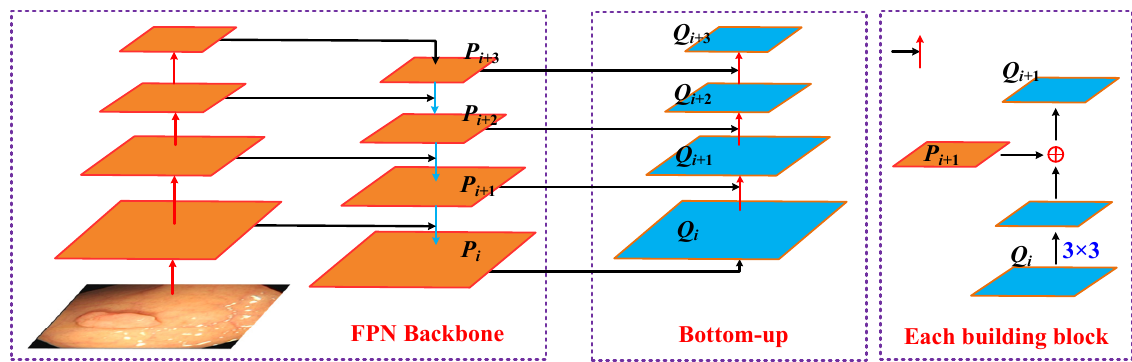
Figure 4. Illustration of Path aggregation network.